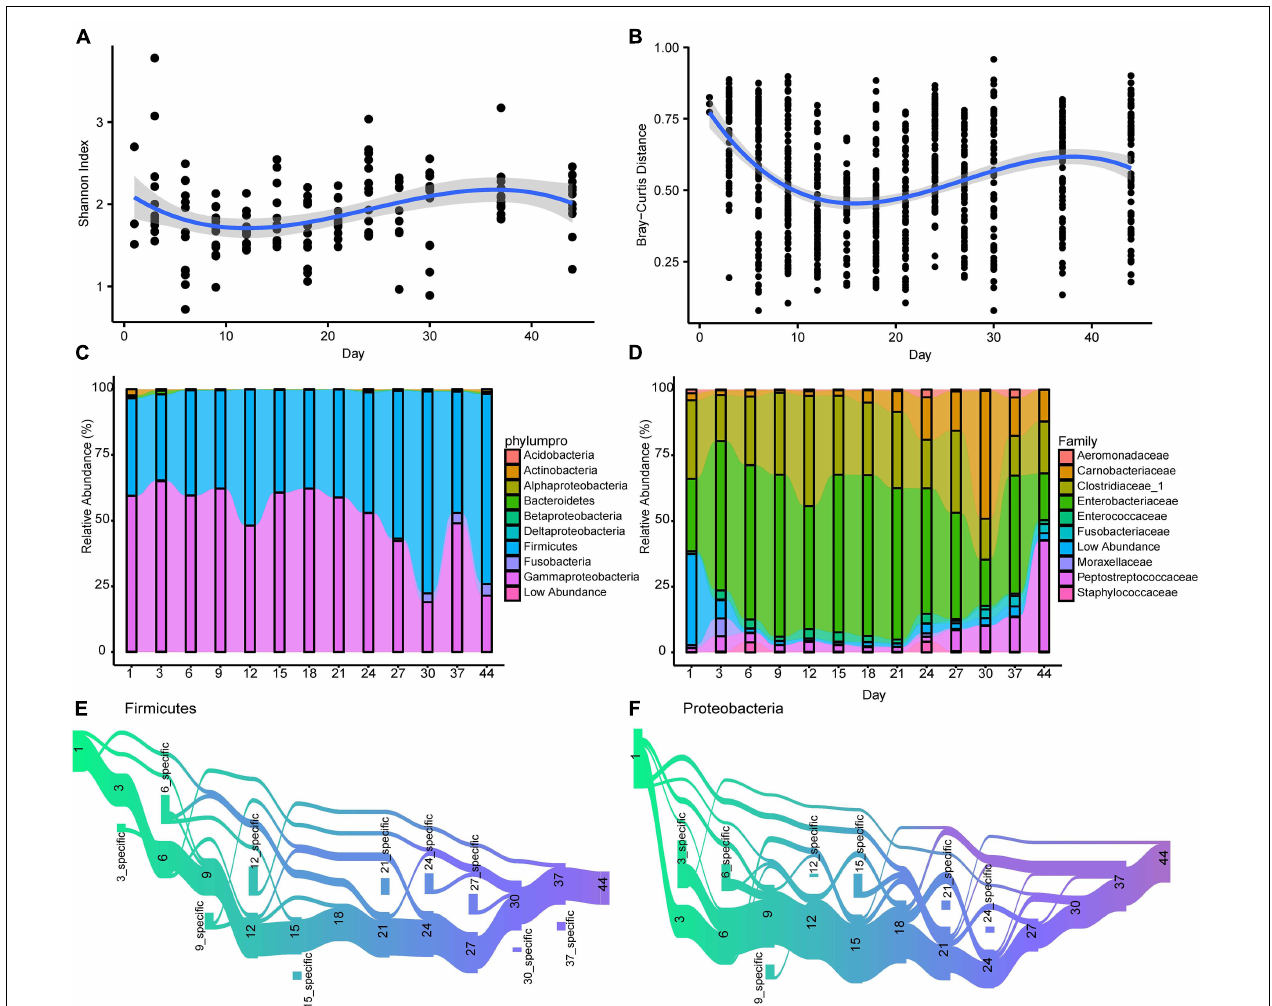
FIGURE 2 | The longitudinal dynamic of gut microbiota in Crested ibis. (A) The alpha diversity of gut microbiota over time. The shadow around the lines reveals 95% CI. The alpha diversity was estimated using the Shannon index. (B) The beta diversity of gut microbiota over time. The Bray-Curtis distance calculated at the ASV level across microbiota from samples collected at the same time point. Higher values denoted more dissimilar gut microbiota. Samples difference in sequencing library size were normalized to 50,000 reads. (C) The temporal changes of bacterial relative abundance at the phylum/class level (top 10). (D) The temporal changes of bacterial relative abundance at the family level (top 10). (E,F) ASVs that the mean relative abundance across all samples larger than 0.1% are tracked using Sankey plots for both Firmicutes and Proteobacteria. The heights of the rectangles show the relative number of ASVs, and each time point has a distinct color. The lines represent the transfer of ASVs among different time